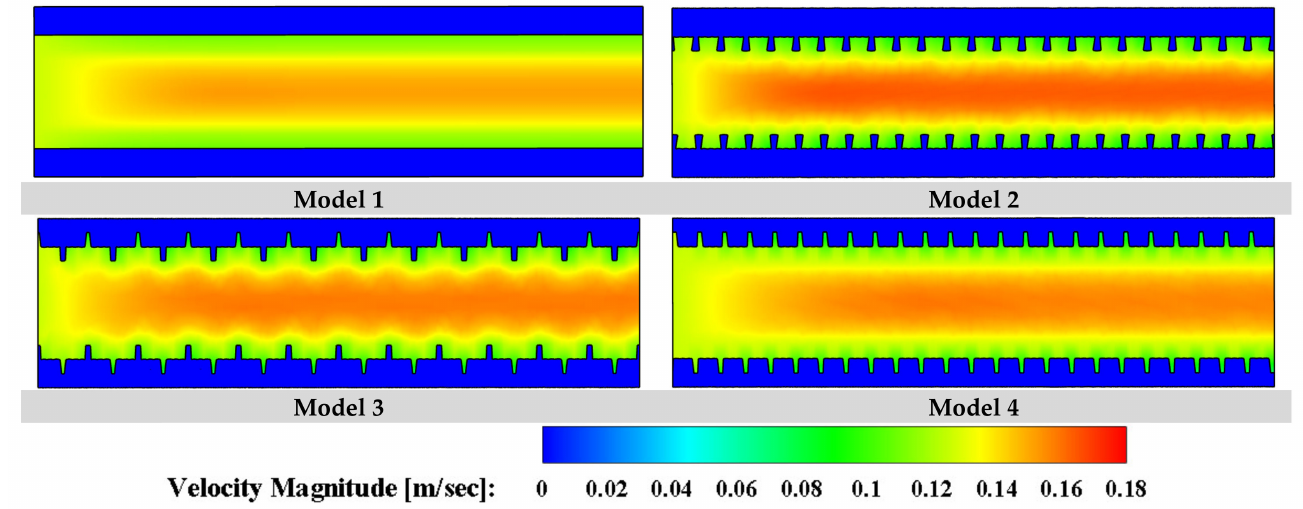
Figure 12. Contours of velocity magnitude at surface X = 0 for various models at P = 500 mm and V Inlet = 0.1256